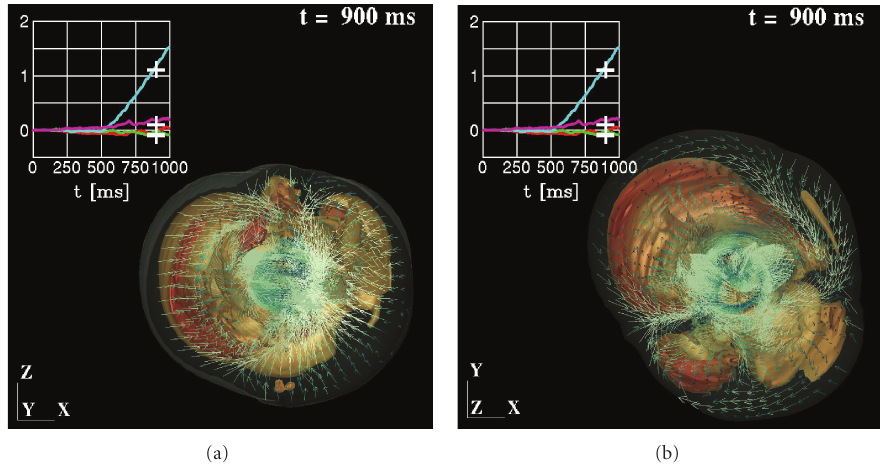
Figure 12: Partial cutaway of the entropy isosurfaces and the velocity vectors on the cutting plane for a 3D model that includes rotation. Left and right panels are for the equatorial and polar observer, respectively. The insets show the gravitational waveforms with “+” on each curves representing the time of the snapshot. Note that the colors of the curves are taken to be the same as the top panel of Figure 10. This figure is taken from